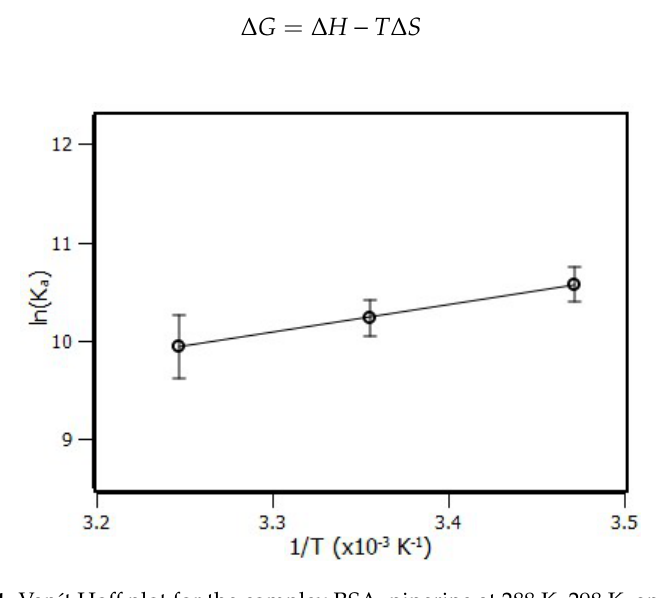
Figure 4. Van´t Ho ff plot for the complex RSA–piperine at 288 K, 298 K, and 308 K. Figure 4. Van´t Hoff plot for the complex RSA–piperine at 288 K, 298 K, and 308 K. Table 2. Thermodynamic parameters of the complex RSA–piperine at 288 K, 298 K, and 308